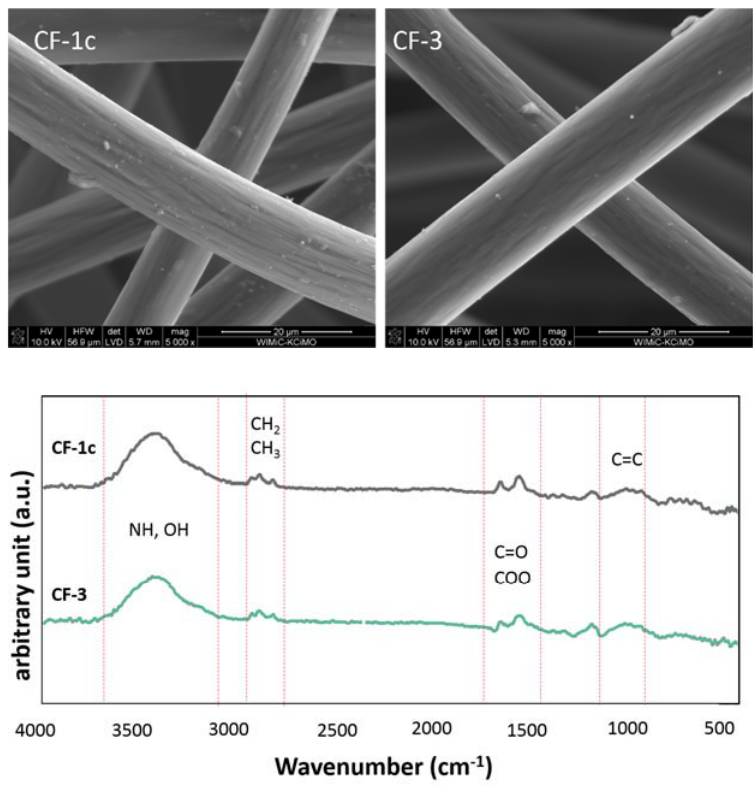
Figure 9. SEM images of modified carbon nonwoven fabric CF-1c and CF-3 and FTIR-DRIFT spec- trum of CF-1c and CF-3 .